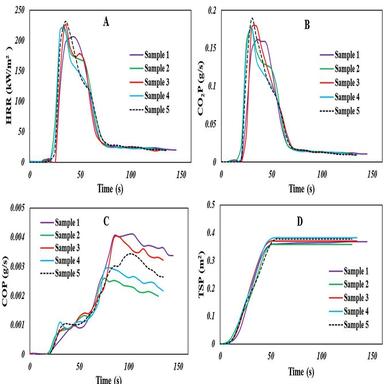
Cone calorimeter results of individual RH biomasses obtained by subjecting the samples to radiative heat from a cone heater (A. Heat released rate, HRR; B. Carbon dioxide production rate, CO2P; C. carbon monoxide production rate, COP; D. Total smoke production, TSP). (For interpretation of the references to colour in this figure legend, the reader is referred to the web version of this article.)